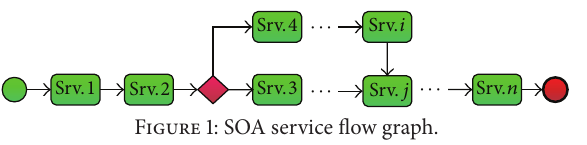
Figure 1: SOA service flow